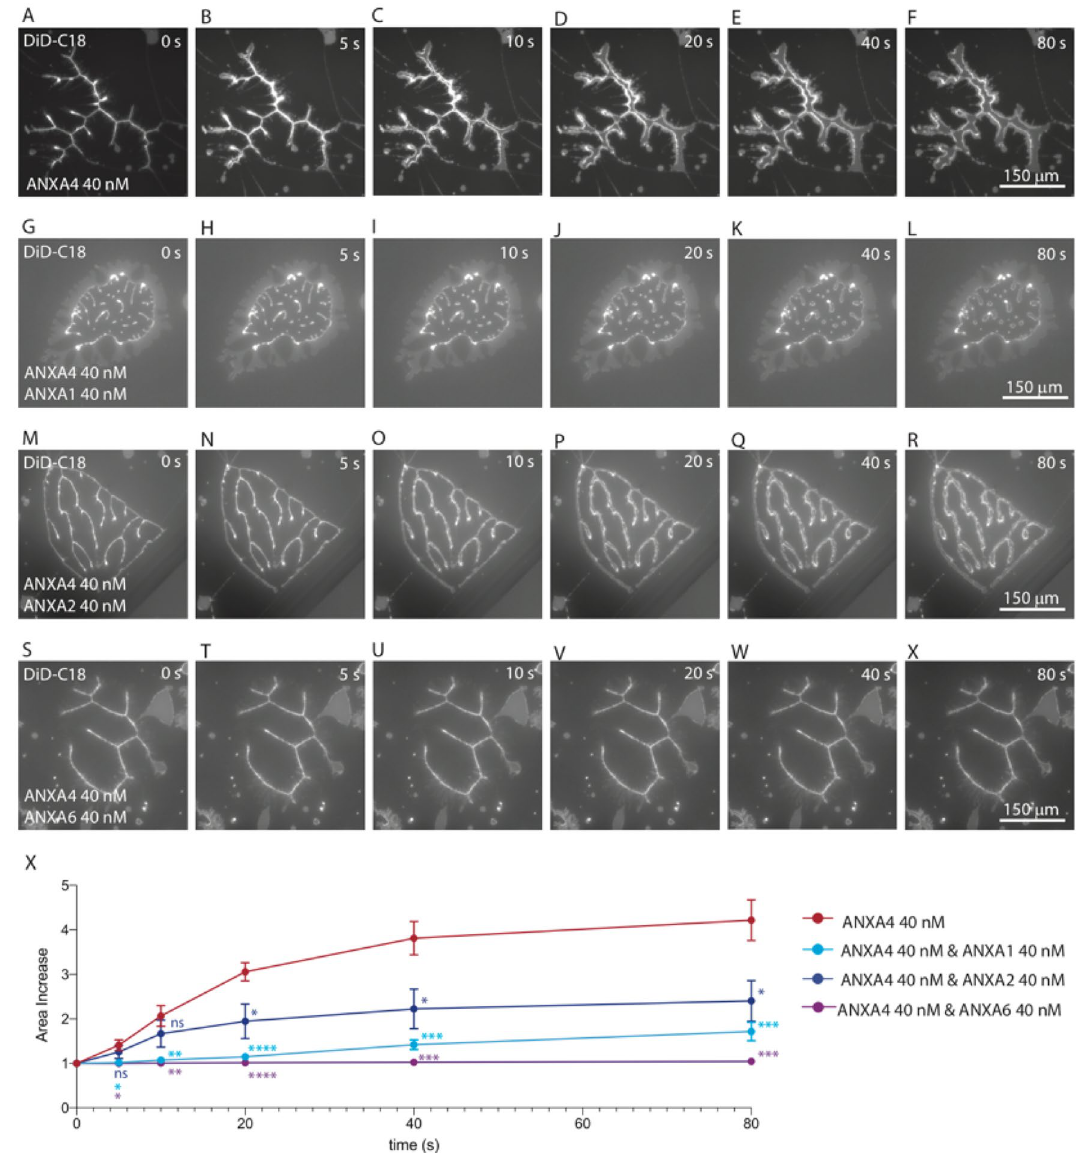
Figure 5. Hindrance of membrane patch unrolling by crosslinking annexins. Time course of membrane patches unrolling from maximally rolled state for ANXA4 ( A – F ), ANXA4 and ANXA1 ( G – L ), ANXA4 and ANXA2 ( M – R ) and ANXA4 and ANXA6 ( S – X ). Relative area increase over time shown for ANXA4 (red), ANXA4 and ANXA1 (light blue), ANXA4 and ANXA2 (dark blue) and ANXA4 and ANXA6 (purple) ( X ). Results of